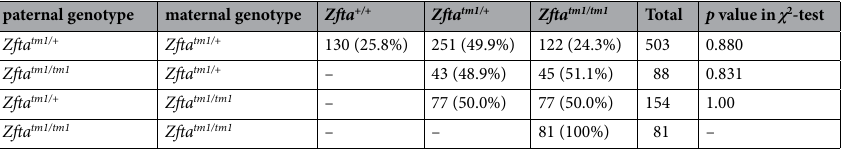
Table 1. Numbers and percentages of P21-28 mice obtained from Zfta tm1 mutant mice breeding pairs.